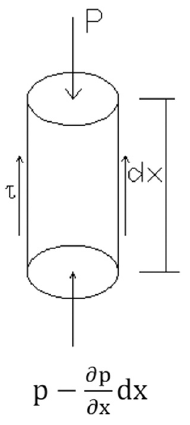
Figure 2: Equilibrium of differential unit.